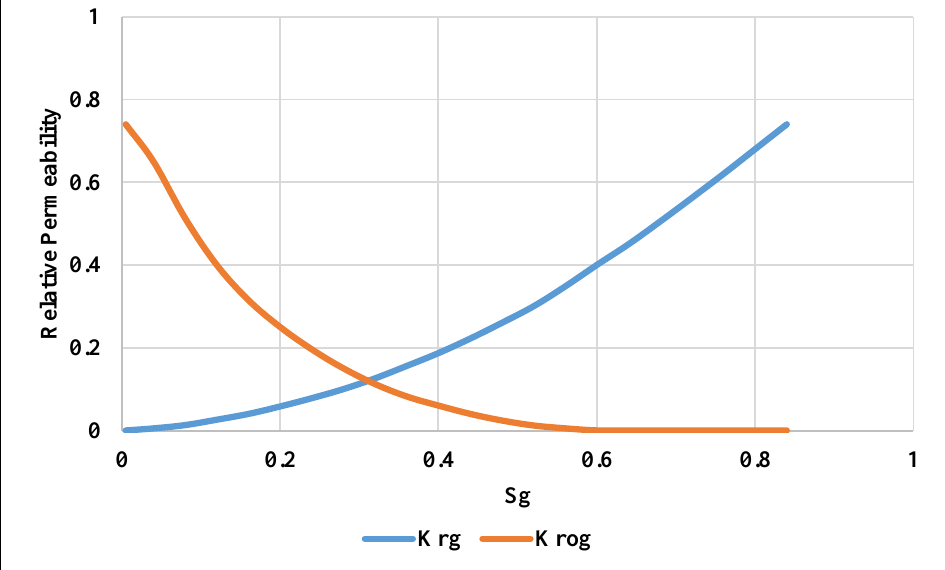
Figure 10. Gas (K rg ) and oil (K rog ) relative-permeability curves used in this study.